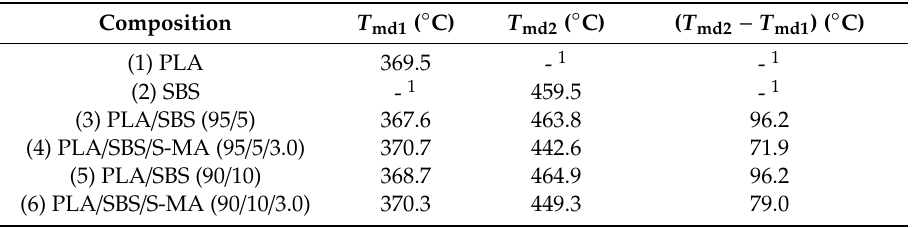
Figure 4. ( a ) Thermal gravimetric analysis (TGA) and ( b ) derivative thermogravimetric (DTG) thermograms at a heating rate of 10 ◦ C / min for (1) (neat) PLA, (2) (neat) SBS triblock copolymer, blends of PLA and SBS (95 / 5 w / w) (3) uncompatibilized and (4) compatibilized with 3.0 wt % of S-MA, and blends of PLA and SBS (90 / 10 w / w) (5) uncompatibilized and (6) compatibilized with 3.0 wt % of S-MA. In graph ( a ), the inset is a magnification of the onset regions of thermal decomposition; in graph ( b ), the insets in the lower left and upper left corners, respectively, are magnifications of the two sequential maximum decomposition-rate regions. Table 2. The temperatures ( T md1 and / or T md2 ) at maximum decomposition rates, analyzed from Figure4bDTGtraces, for(neat)PLA,(neat)SBS,andPLA / SBS(95 / 5and90 / 10w / w)blendscompatibilized with di ff erent concentrations (0 and 3.0 wt %) of